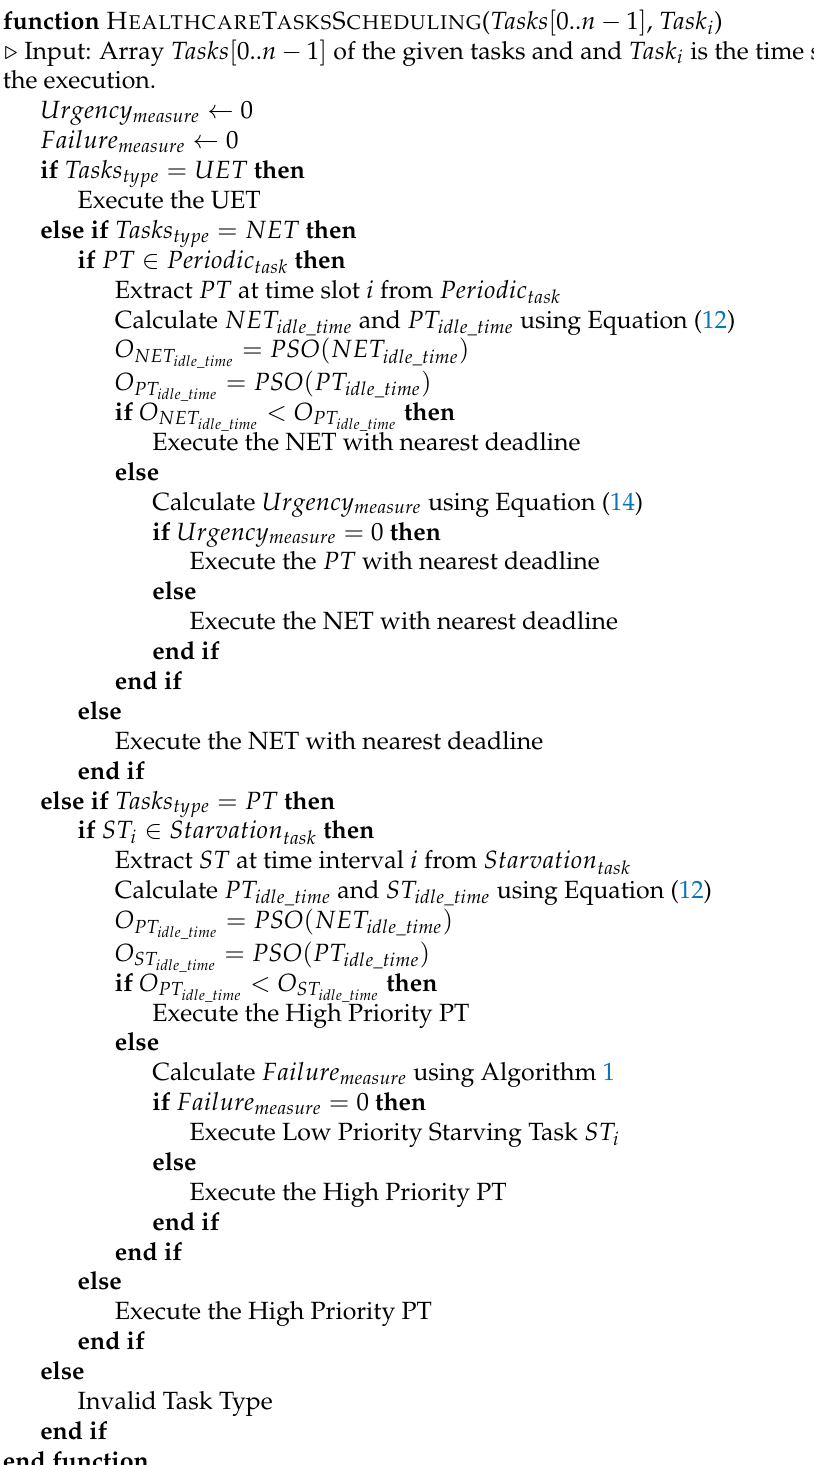
Algorithm 2 An Optimized Time-Constraint Aware Scheduling